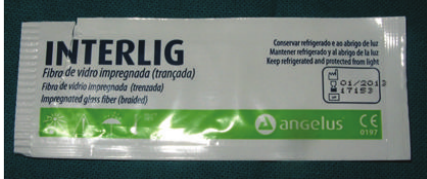
Figure 4: Interlig (fibre impregnated with composite resin).